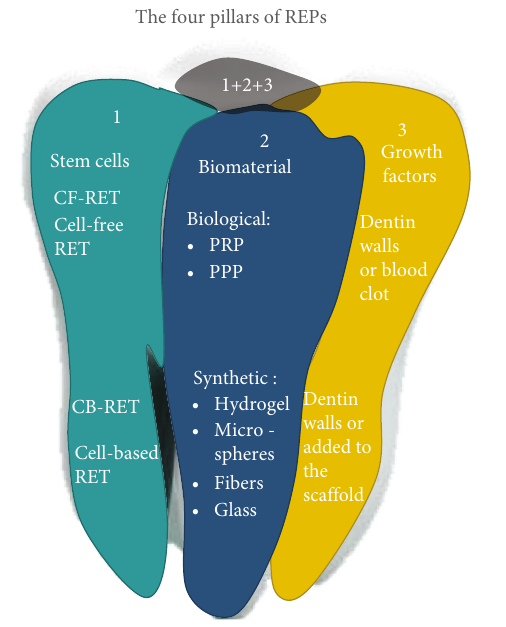
Figure 1: The four pillars of REPs: 1 Stem cells, CF-RET: exogenous stem cells and CB-RET: exogenous stem cells. 2 Biomaterials: Biological PRP: platelet-rich plasma or PRF: platelet-rich. 3 Growth factors (GF): From dentin walls and blood clot or GF-impregnated sca ff old. 4 Synergistic interactions